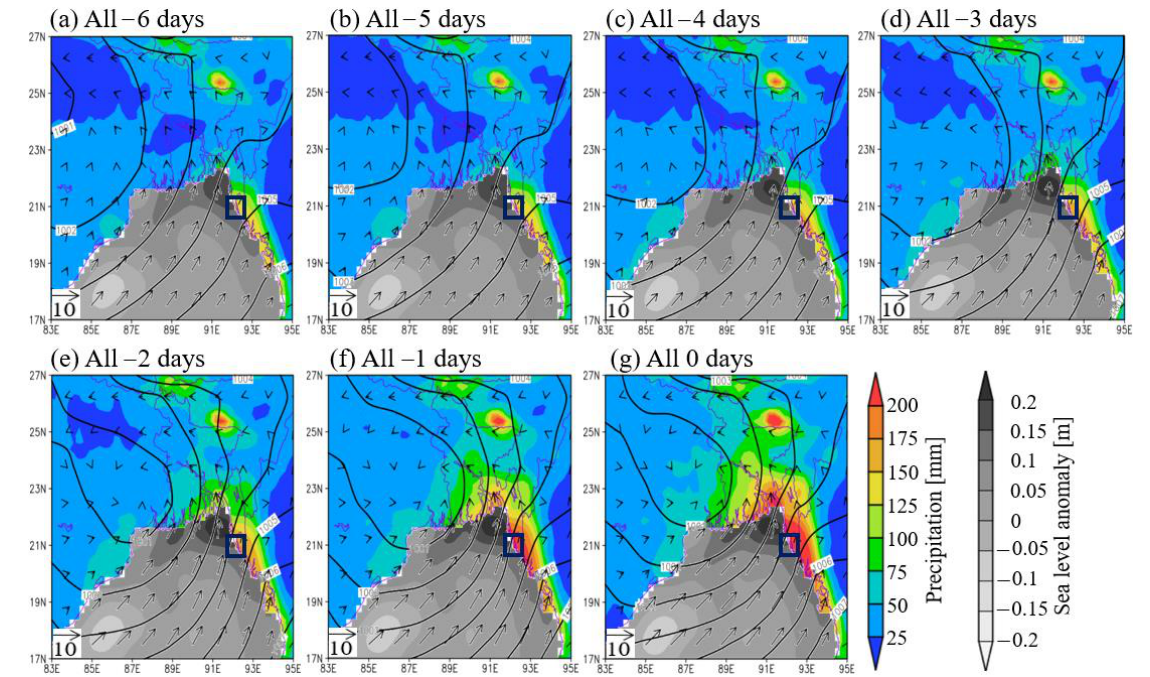
Figure 7. Composite map of the variables for each prior day ( a – f ) and the day of extreme ( g ) for all ESL events at Cox’s Bazar during 1993–2006. Here, the analysis was performed for the period 1993–2006, considering the availability of gridded SLA data. The gray shading over the ocean represents SLA (m), and the color shading over the land represents accumulated precipitation during the five preceding days (mm). The contour and vector are for SLP (hPa) and surface wind (m/s), respectively. The rectangles denote the location of the Cox’s Bazar station. Please note that the sea level anomaly drawn here is defined as the deviation of sea level from its 20-year (1993–2012) climatological mean [37].